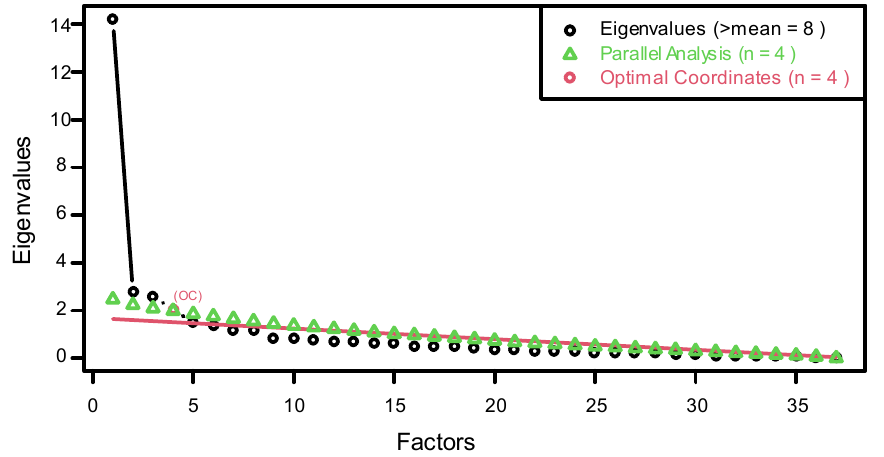
Figure 7. Scree plot for the remaining 37 items with corresponding eigenvalues and dimensions as well as a parallel analysis.